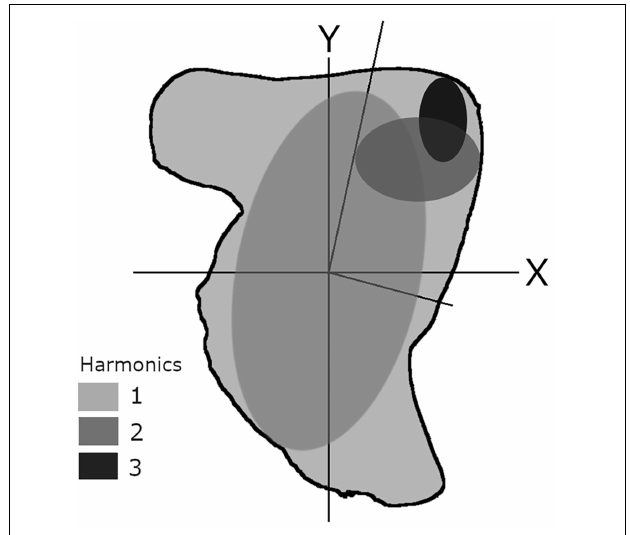
FIGURE 3 | Theoretical schematic showing the elliptic Fourier approximation of a cephalopod statolith, using three harmonics (method based on Crampton, 1995).